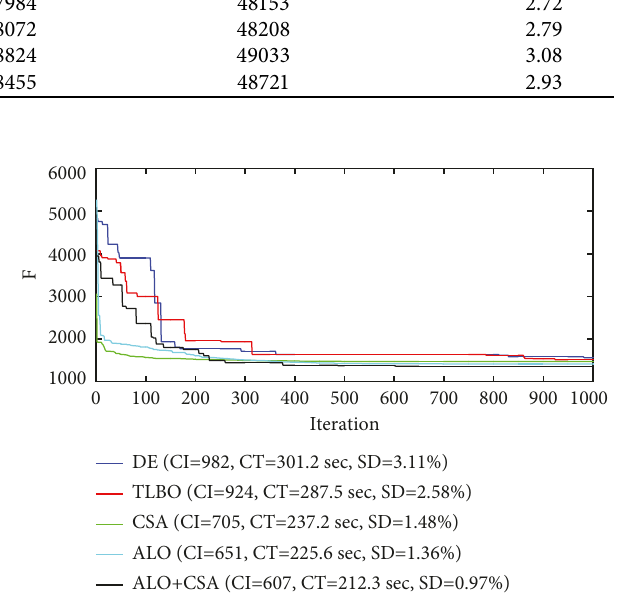
Figure 4: Convergence curve of the proposed problem based on the different